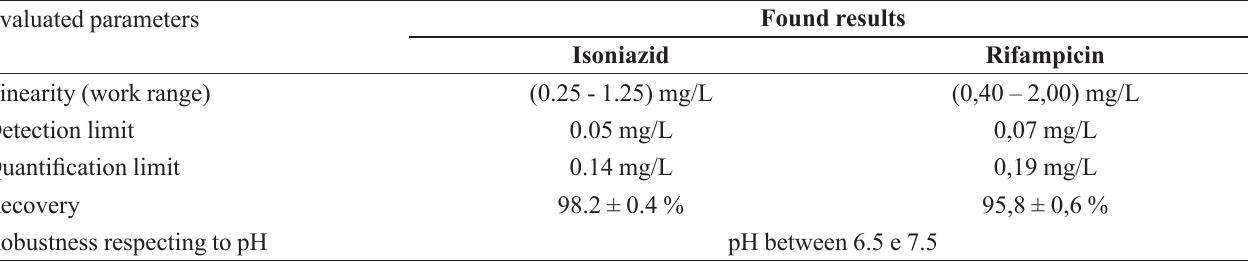
TABLE III – Evaluated parameters in the validation of electroanalytical methodology, according to document of INMETRO, 2007 Evaluated parameters